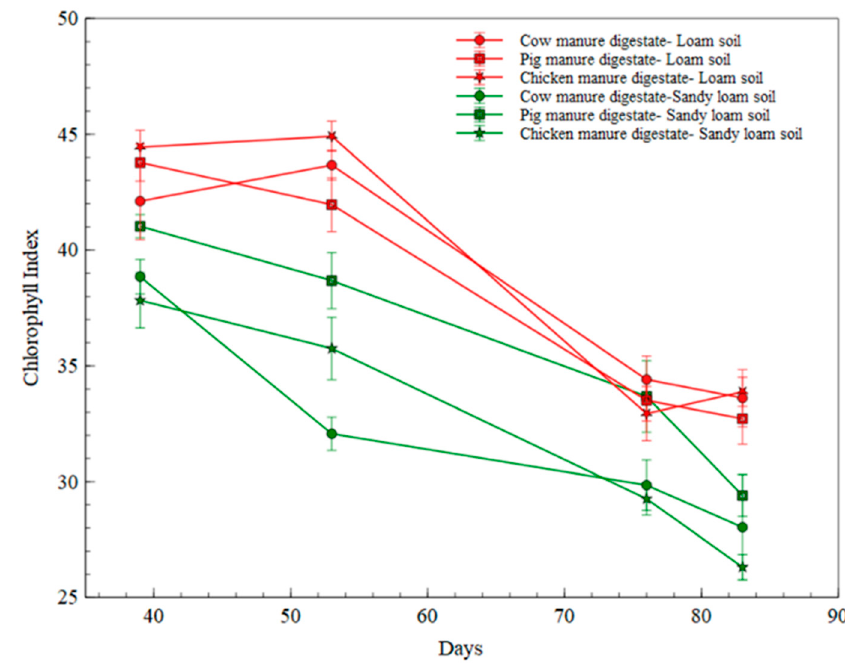
Figure 7. Chlorophyll Index measurement in digestate treatments in soil types. The chlorophyll fluorescence in the loam soil was observed to be lower in synthetic nitrogen fertilizer at the early stage of cultivation with a sustained decrease towards the end of the cultivation period (as illustrated in Figure 8). All the digestates showed a consistently higher chlorophyll fluorescence in the cultivation period, with the pig manure digestate fertilized treatment maintaining the high level with control while other treatments decreased towards the harvesting period. Pig manure digestate fertilized loam soil was significantly different ( p < 0.05) to that of the control and the other treatments. The unfertilized pot had a higher fluorescence towards the harvest period from day 70 to day 85.